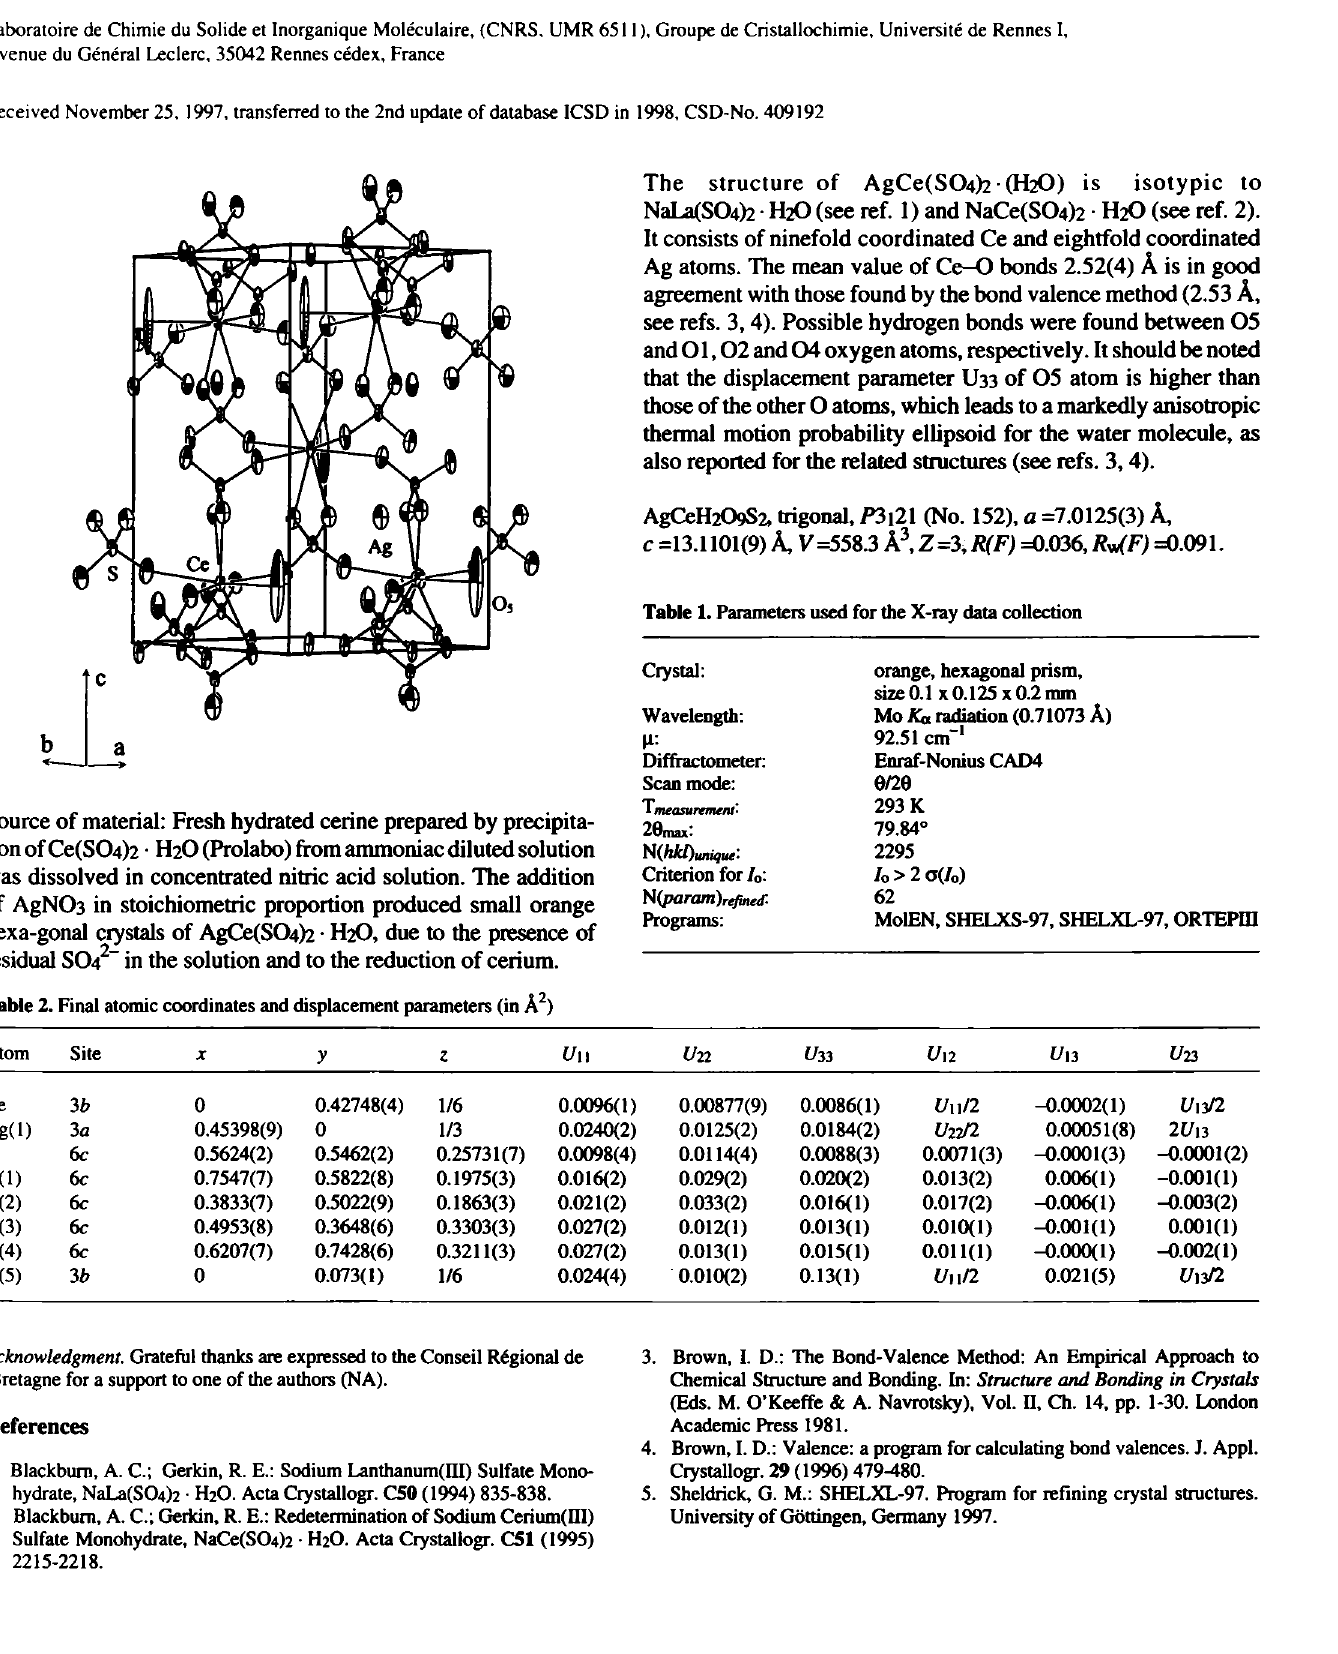
Table 1. Panuneteis used for the X-ray data collection Crystal: Wavelength: μ: